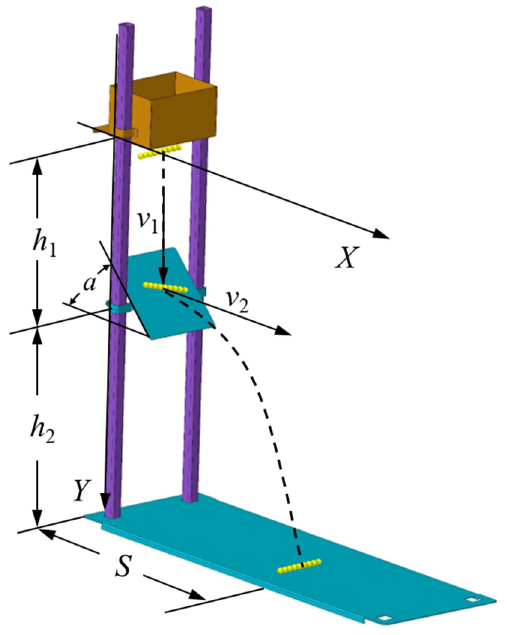
Figure 2. Test of the rape stems’ coefficient of restitution. h 1 is the vertical distance between the baffle plate and the center of the test plate, m; α is the angle between the test plate and the horizon, (°); h 2 is the vertical distance between the test plate and the base plate m; v 1 is the normal fractional velocity of rape stem before the collision, m/s; v 2 is the normal fractional velocity of rape stem after the collision, m/s; S is the horizontal distance between rape stem–bottom plate contact point and the center of the test plate, m.